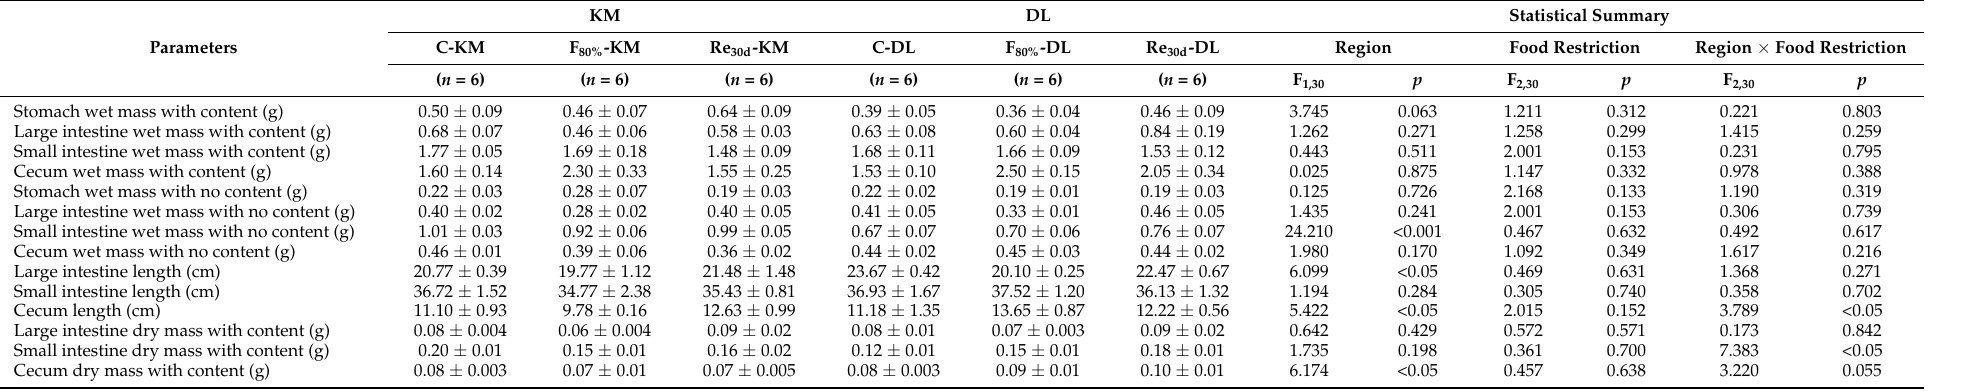
Table 5. Digestive tract changes in E. miletus in different regions under food